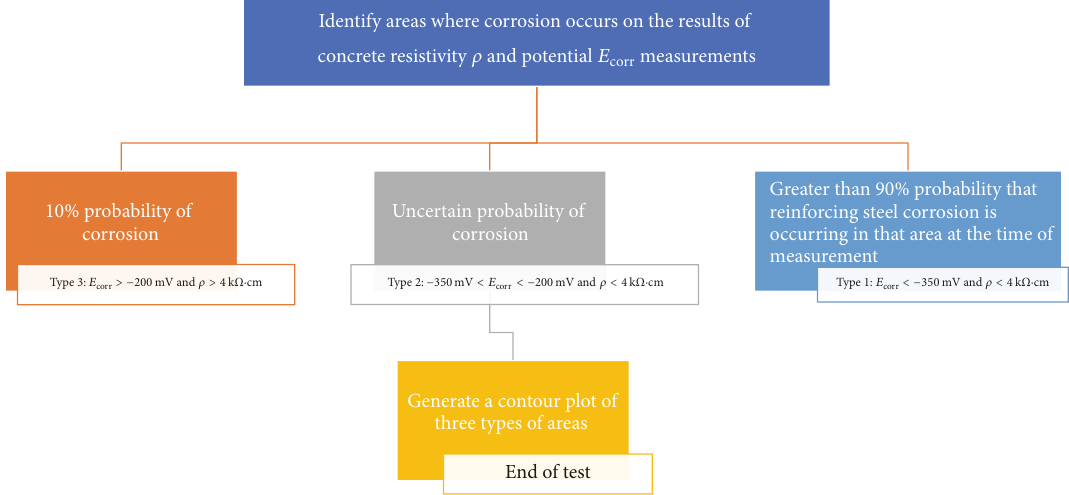
Figure 12: Assessment of corrosion probability in concrete slabs through half-cell potential and resistivity measurements [20].